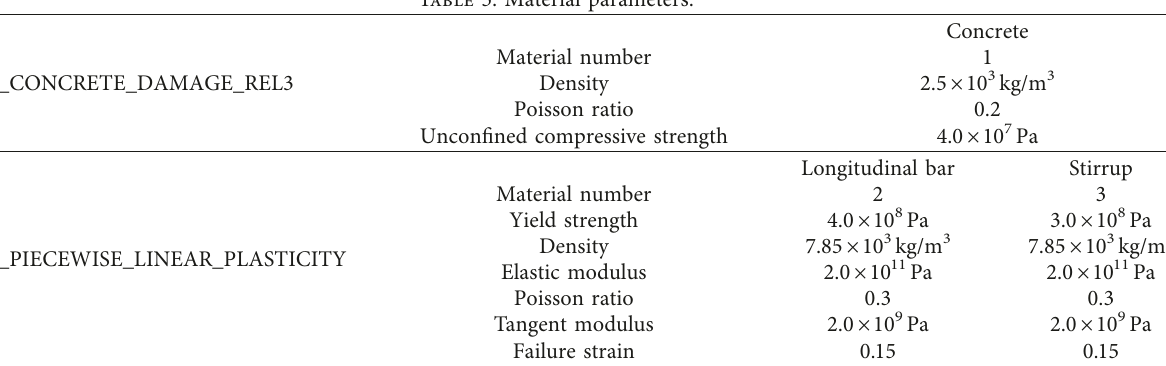
Figure 9: DIF of concrete (a) and steel bar Table 5: Material parameters.